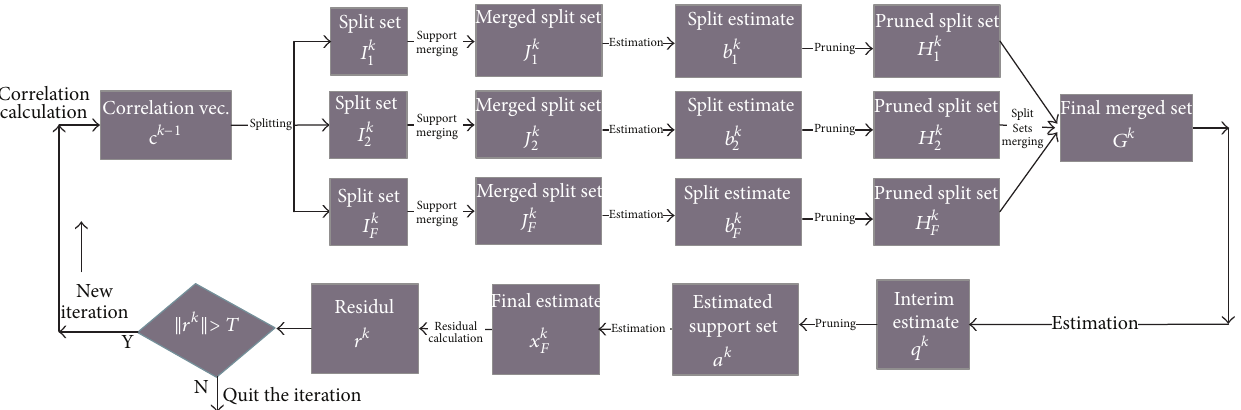
Figure 1: Description of reconstruction procedures of the SMP